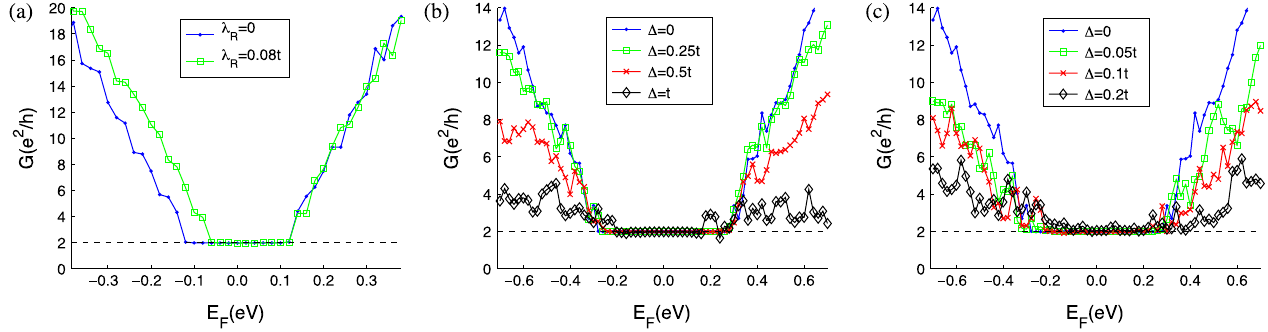
for a system F ¼ 0 : 04 t ; for panels (b) so